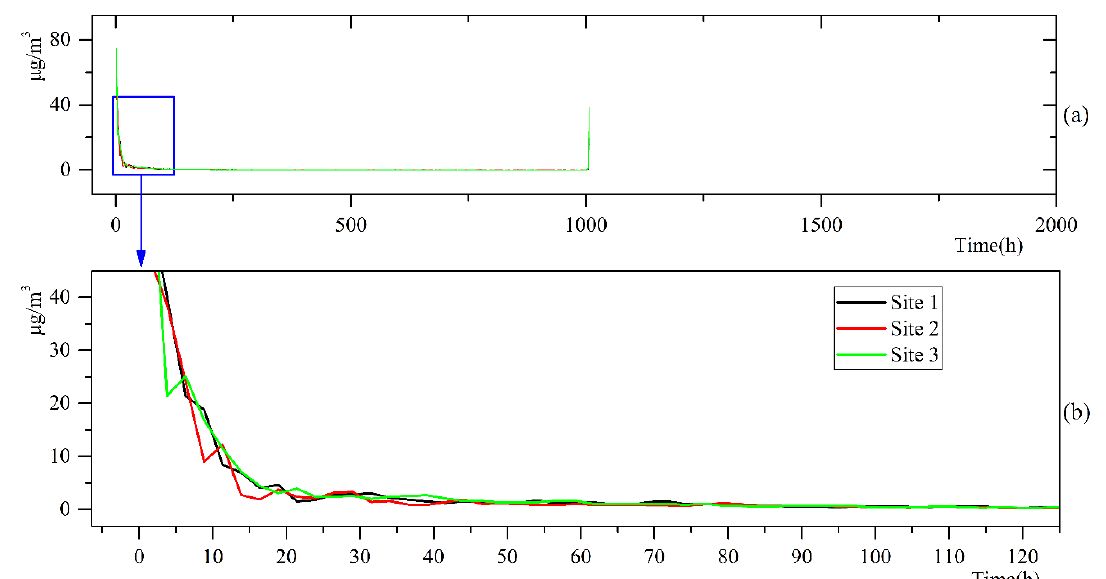
Figure 6. The marginal spectrum of the PM 10 concentration data series ( a ) and the amplification of the blue box ( b ).